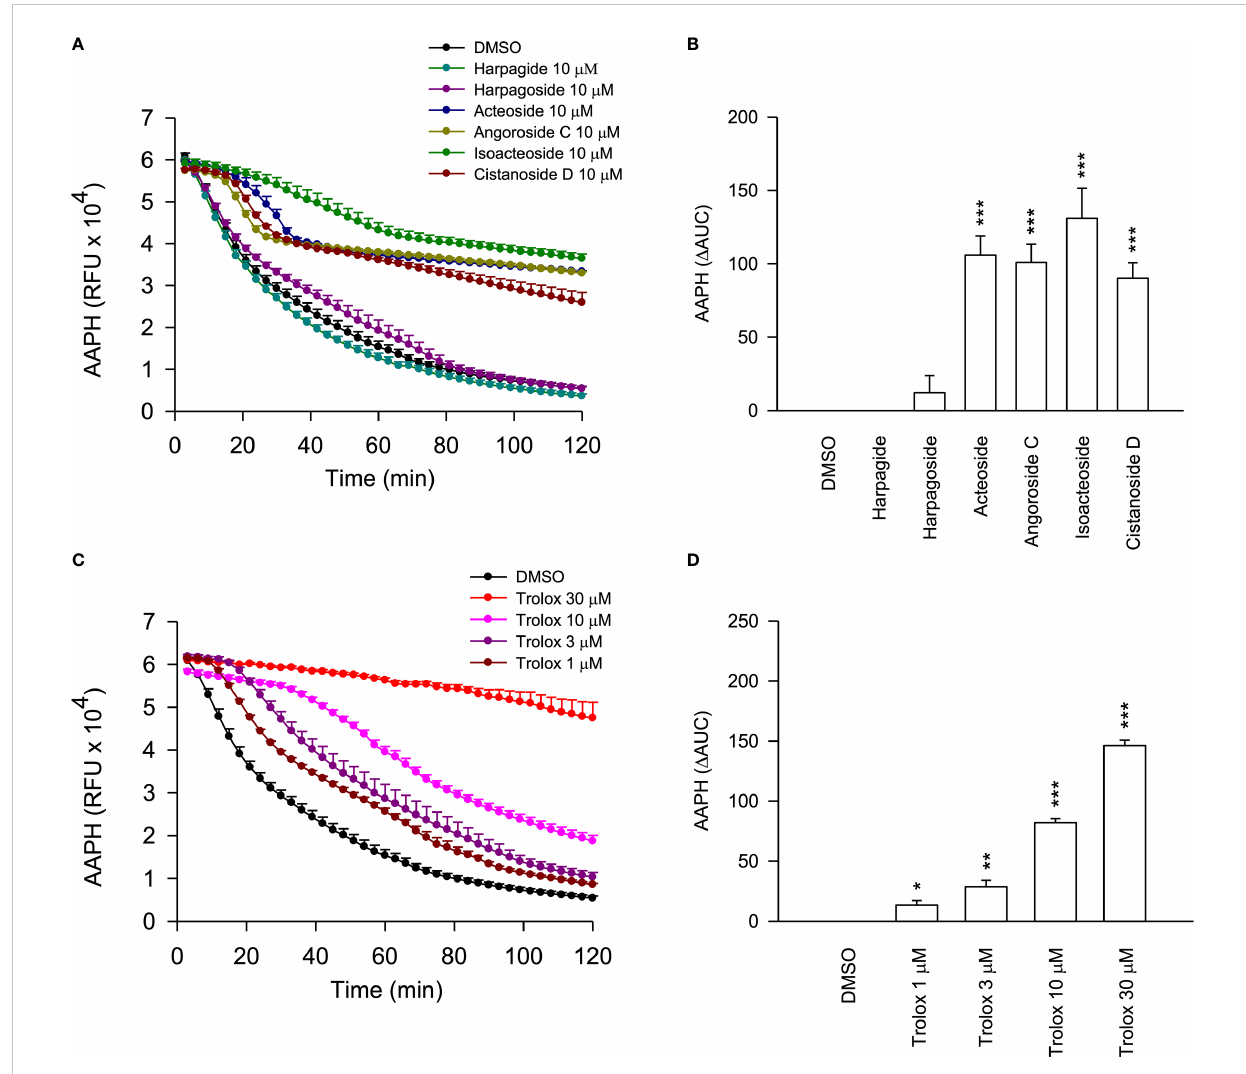
FIGURE 8 The ROS scavenging properties of S. ningpoensis compounds. (A) The fl uorescence decay curves of 2,20-azobis(2-methylpropionamidine) dihydrochloride (AAPH) in the treatments of DMSO (0.1%, as the control), compounds (10 m M), and (C) Trolox (1 – 30 m M, as the positive control). The AUC value was quanti fi ed and shown in (B, D) . The values were shown as the mean ± S.E.M. (n = 4). * p < 0.05, ** p < 0.01, *** p < 0.001 compared with the